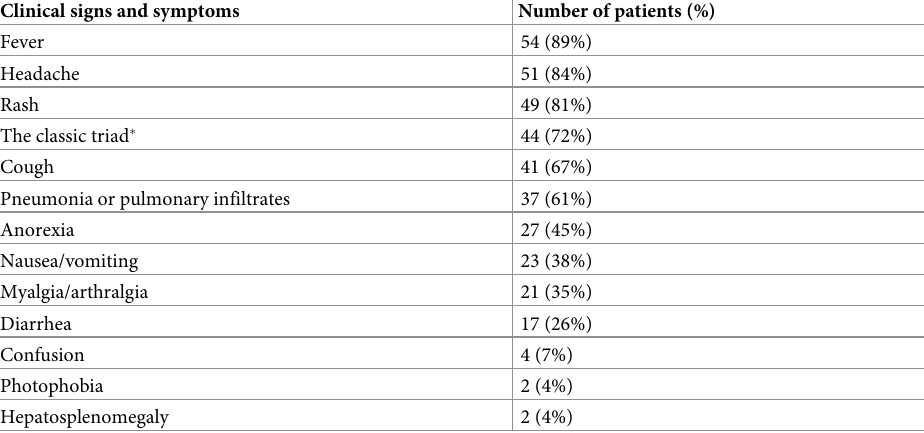
Table 4. Clinical characteristics of murine typhus